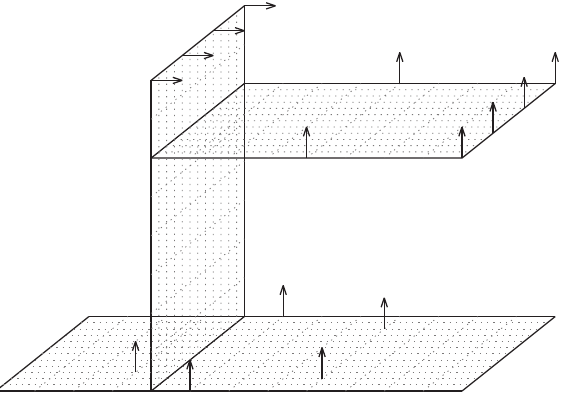
Figure 4: Scenario with 15 active DOFs according to the EIM.